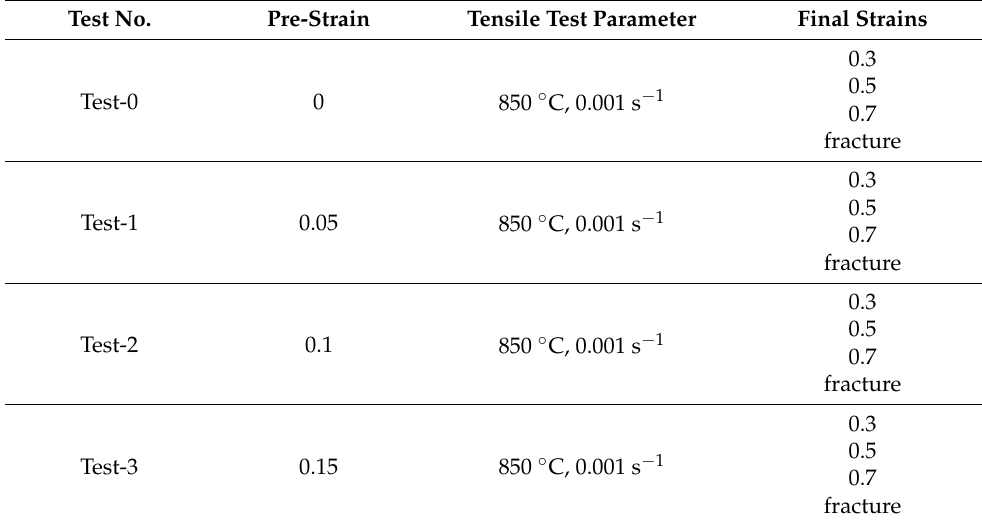
Table 1. Experimental schemes of hot tensile test. Test